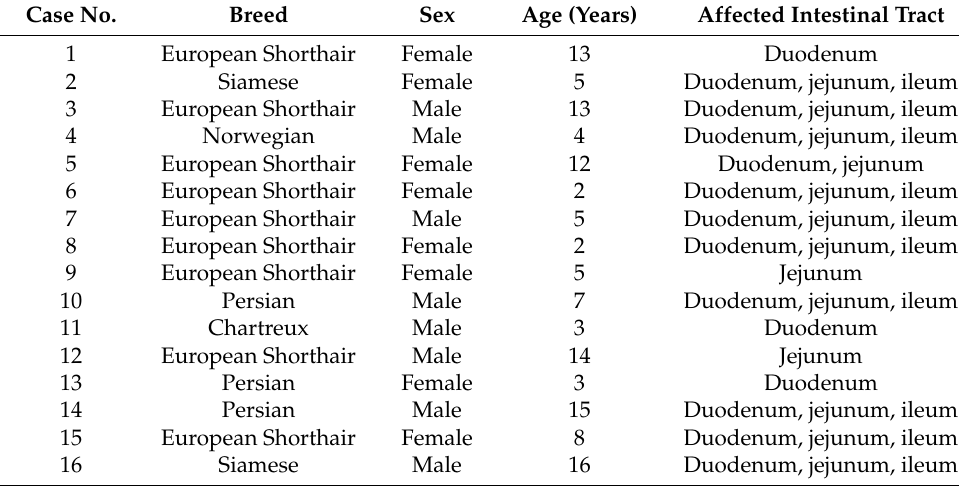
Table 1. Cases included in the study. Case No.